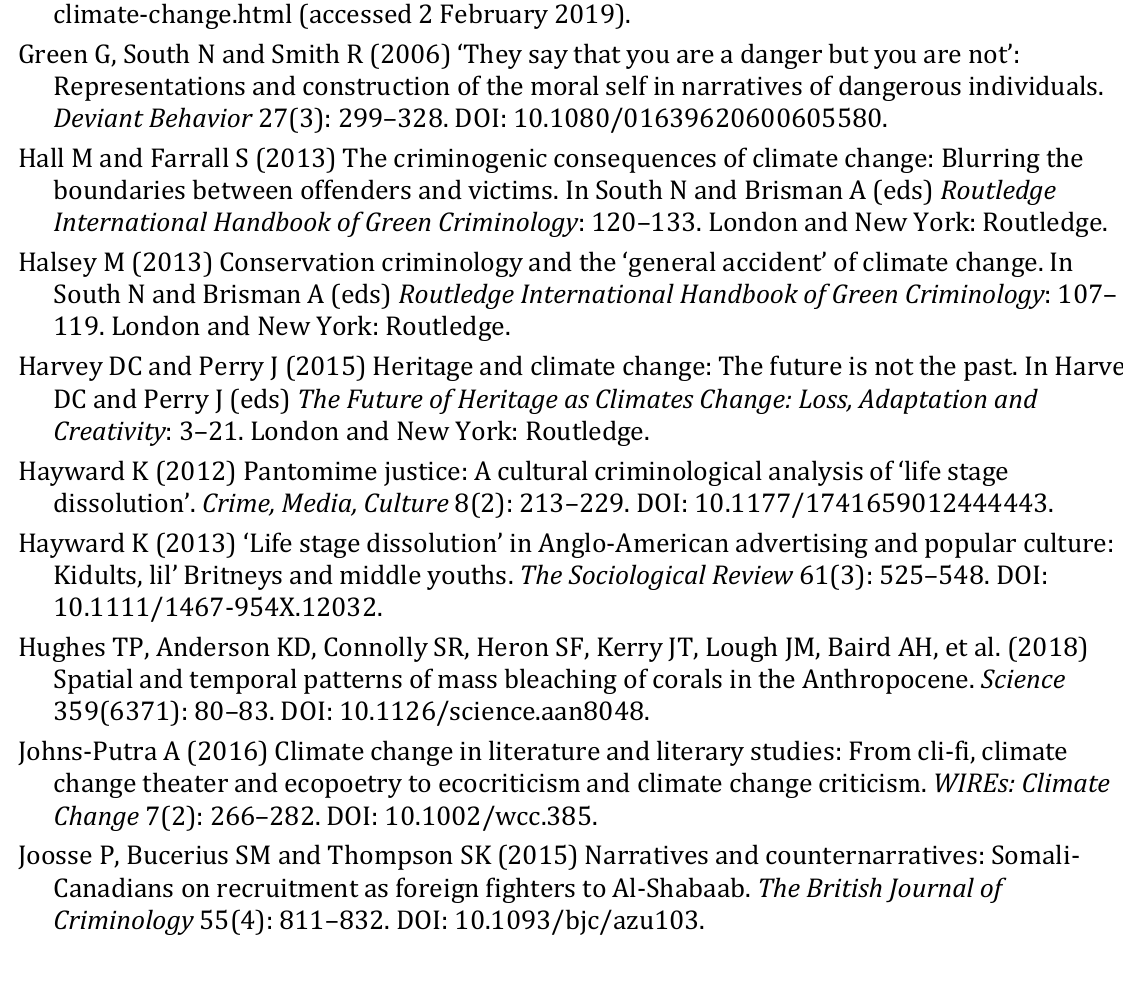
Figueres C (2017) The diplomat behind the Paris climate agreement says the world is moving forward without Donald